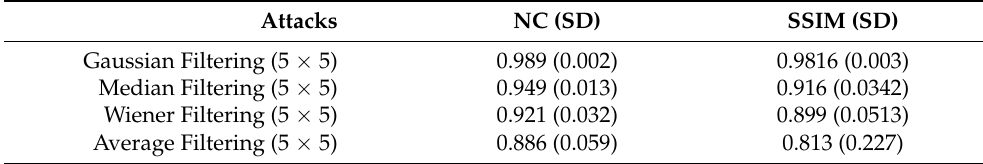
Table 7. Comparison of the NC and SSIM values under various attacks.